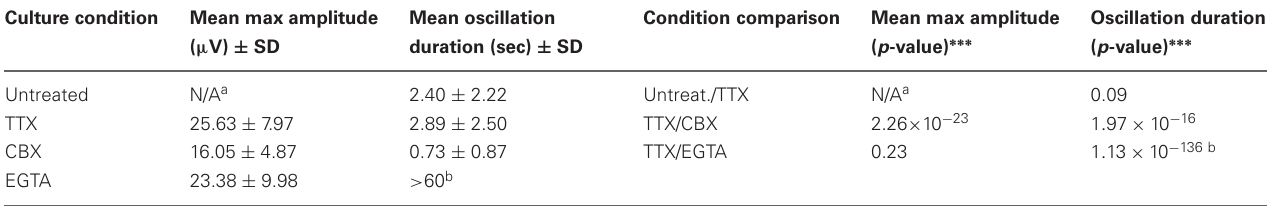
FIGURE 2 | 250–400 Hz oscillation. Average baseline power spectra of electrodes that contain the stimulus-evoked oscillation when a different electrode was stimulated at time 0 (A) , with stimulation at time 0 on the electrode with the oscillation (B) , and with stimulation at Table 1 | Mean amplitude and duration of stimulus-evoked oscillation.